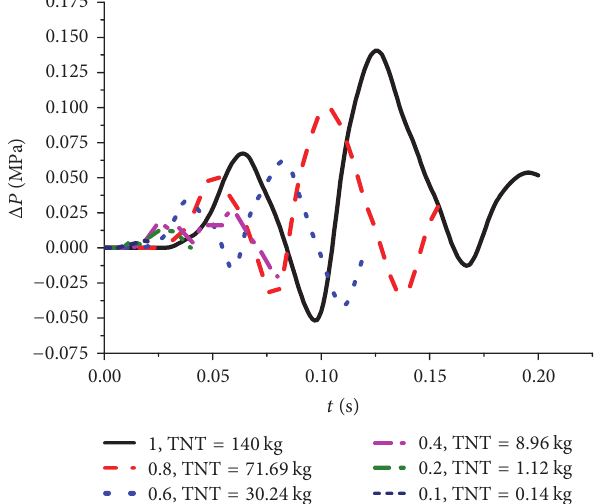
Figure 6: Time-history curve of maximum nodal displacement in scaled models.